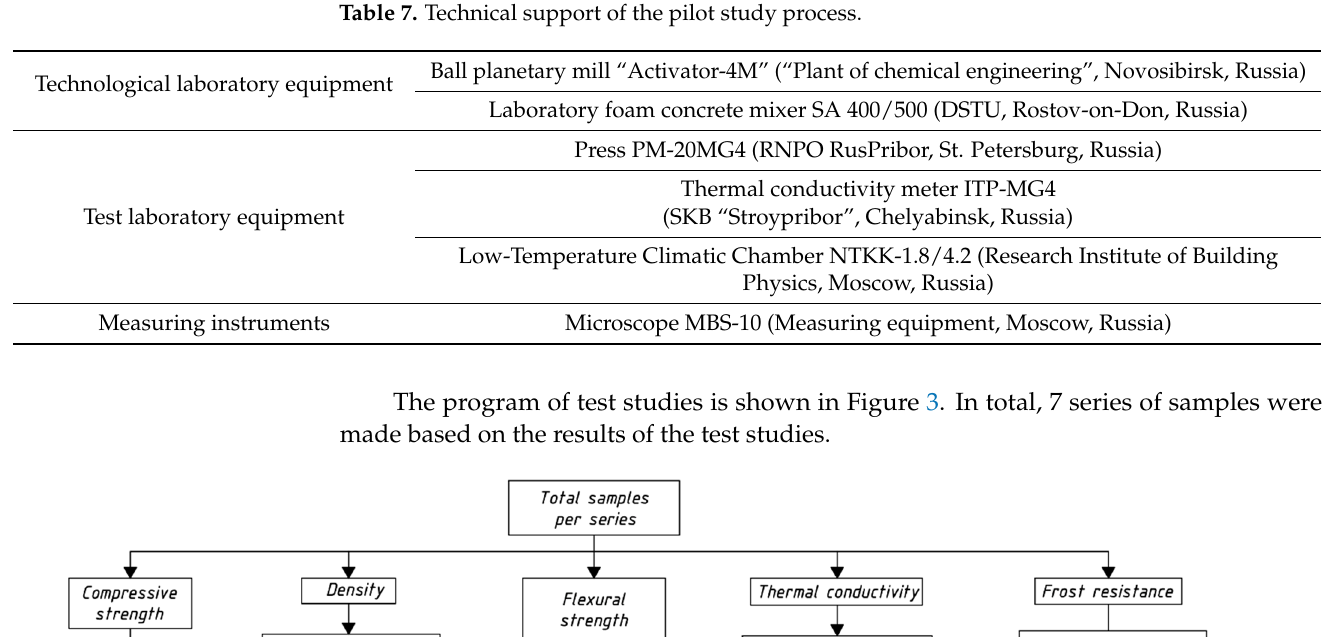
Table 7. Technical support of the pilot study process.